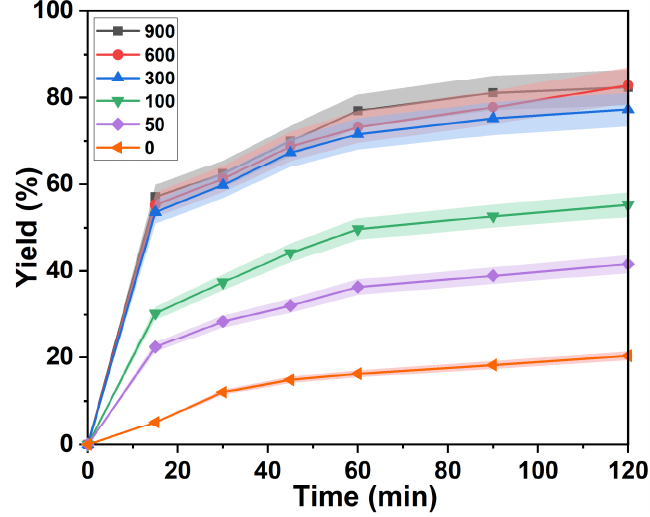
Figure 3. Change of lignin separation yield under different stirring speed.